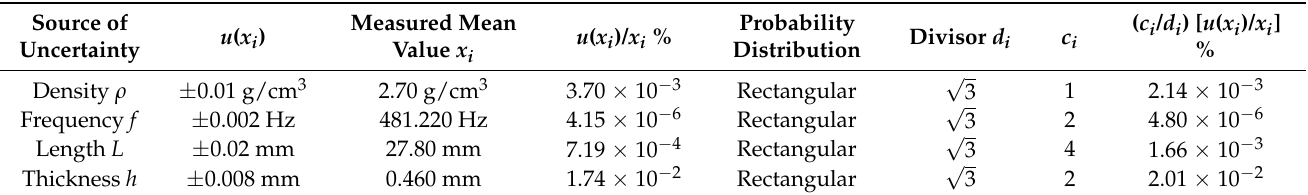
Table 2. Relevant values for the calculation of the dynamic modulus variance for an aluminum probe manufactured by extrusion ( R t = 8 µ m).